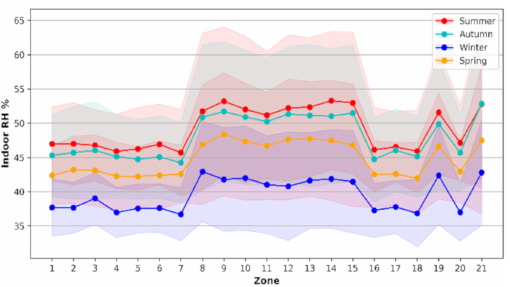
Figure 16. Relative humidity mean per season (hues account for standard